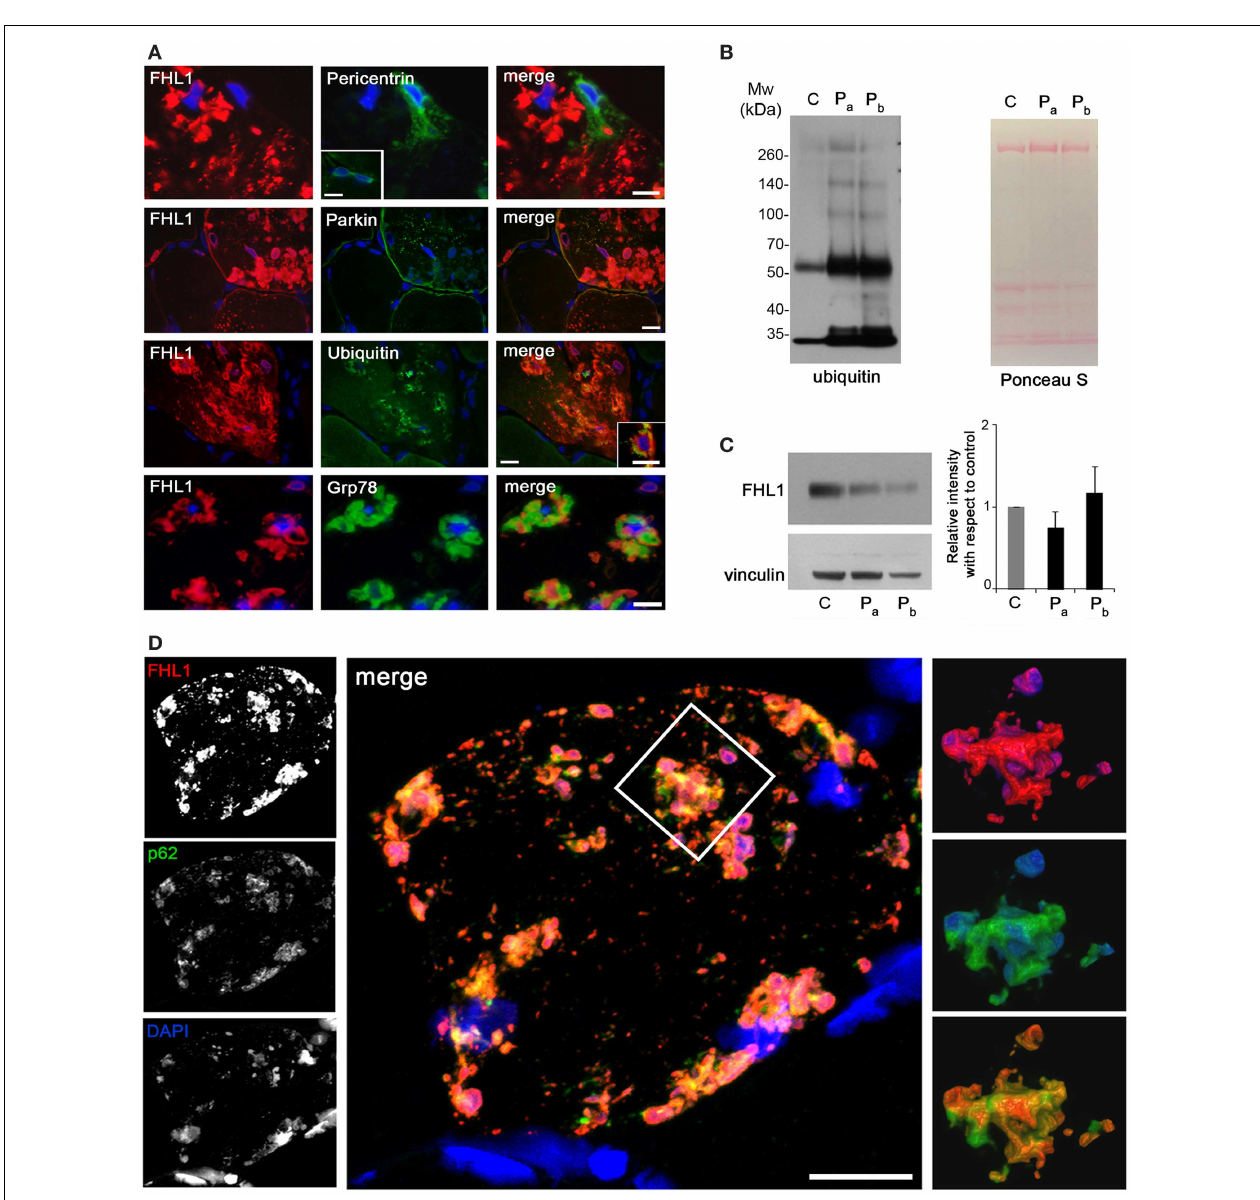
FHL1 protein level showing the relative western blot intensity with respect to control. Densitometric quantification was performed by three independent western blot experiments ( P > 0.05, P a and P b vs C). (D) Confocal immunofluorescence imaging of the patient muscle biopsy labeled with FHL1 antibody (red), p62 antibody (green), and DAPI (blue).The maximum intensity projections of the single channels (white) are shown on the left, the merged image of confocal projections are shown in the middle, and the 3D surface shaded reconstruction of an enlargement of the area defined by the white box is shown on the right. Scale bar, 10 µ